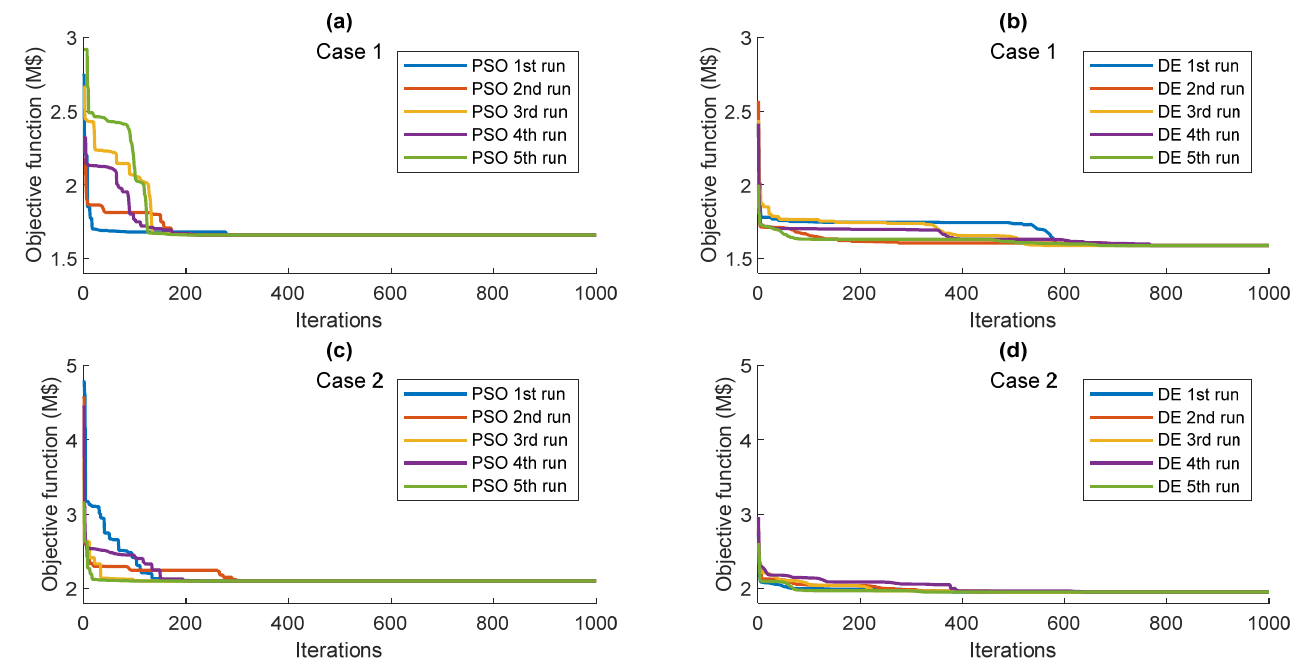
Figure 12. Comparison for Optimal Solution Convergence; ( a ) the PSO Algorithms in Case 1. ( b ) the DE Algorithms in Case 1. ( c ) the PSO Algorithms in Case 2. ( d ) the DE Algorithms in Case 2.